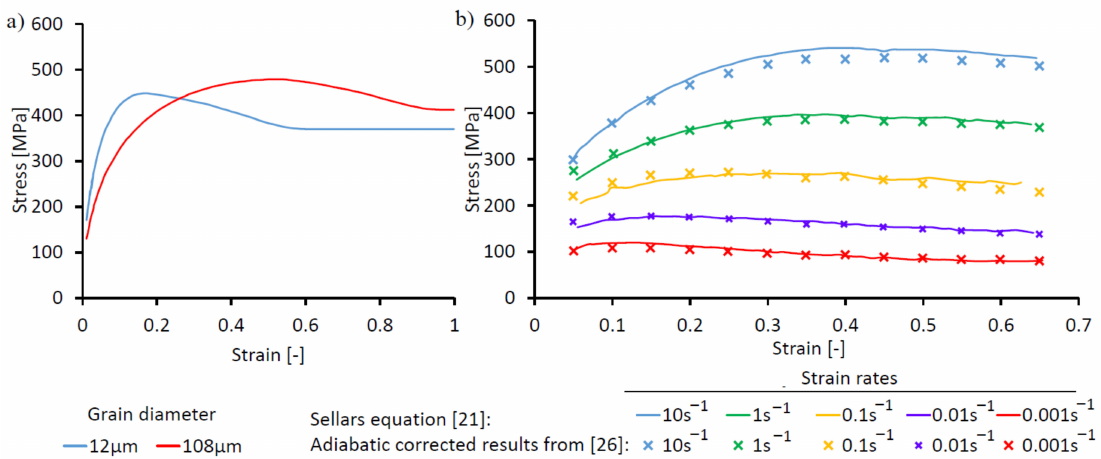
Figure 7. Flow curves at 1000 ◦ C: ( a ) two different grain sizes; ( b ) varying strain rates with Sellars model and experimental